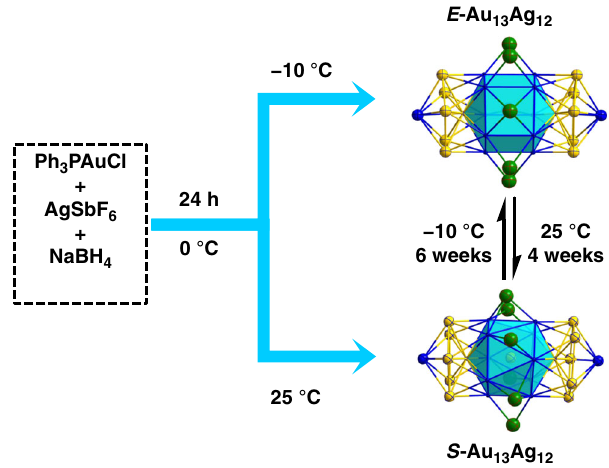
Fig. 1 Two isomers of the [Au 13 Ag 12 (PPh 3 ) 10 Cl 8 ] + (SbF 6 ) ˉ nanocluster with thermally responsive transformation (h = hour). E- eclipsed con fi guration, S- staggered con fi guration. Color code: Au: yellow; Ag: blue; Cl: green (C, H, P, and some Cl are omitted for